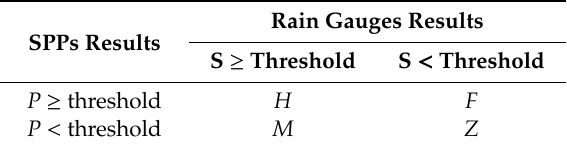
Table 2. Contingency table between SPPs data and observed